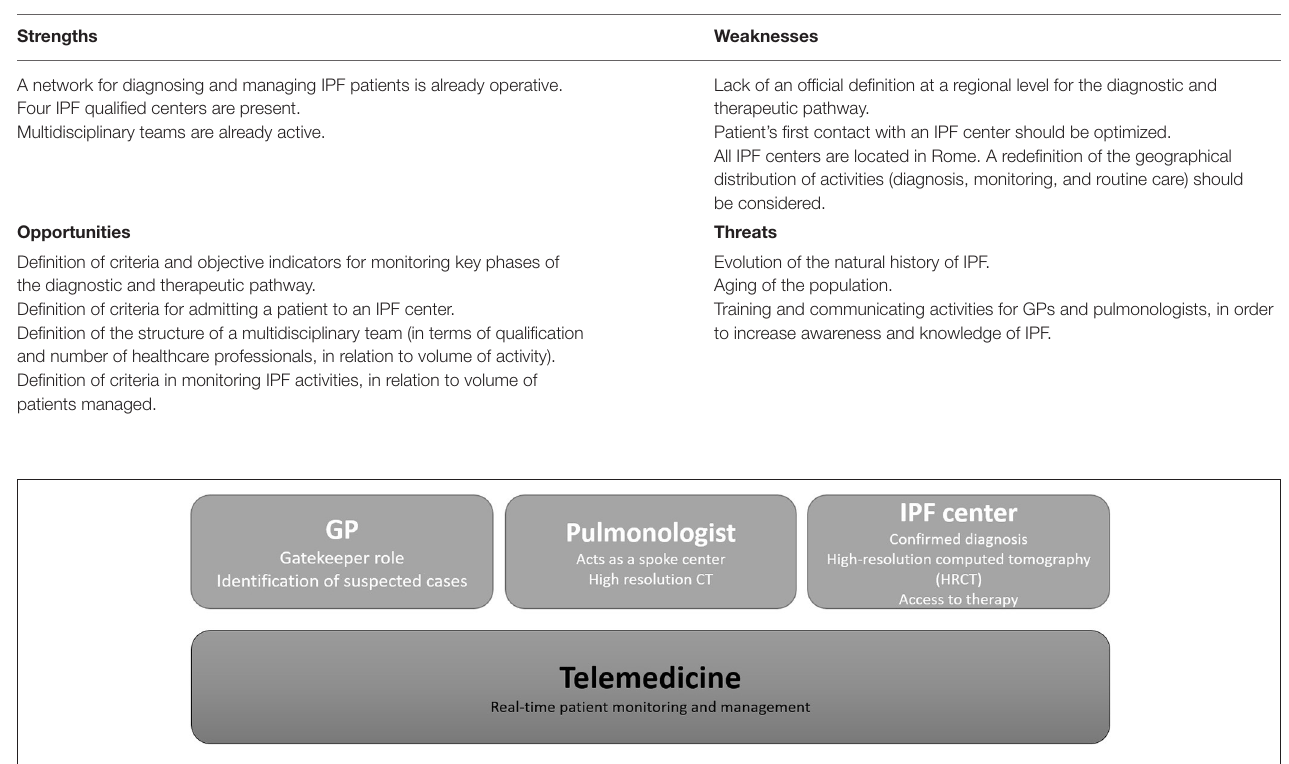
FIGURE 2 | Pillars of a new model of care for IPF in the Lazio